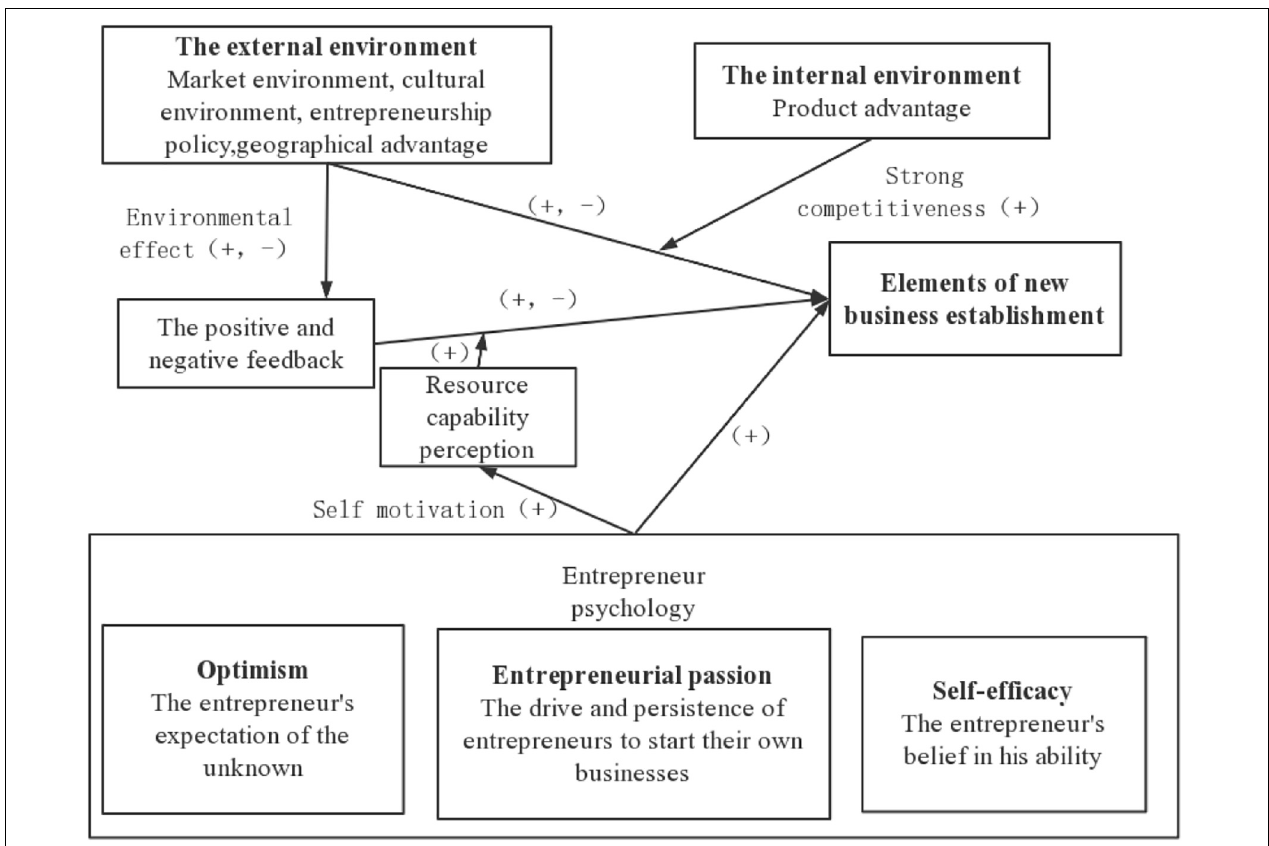
FIGURE 1 | Structure of the elements for the establishments of startups. “(+)” means positive effect , “(–)” means negative effect, “(+,–)” means may have a positive or negative